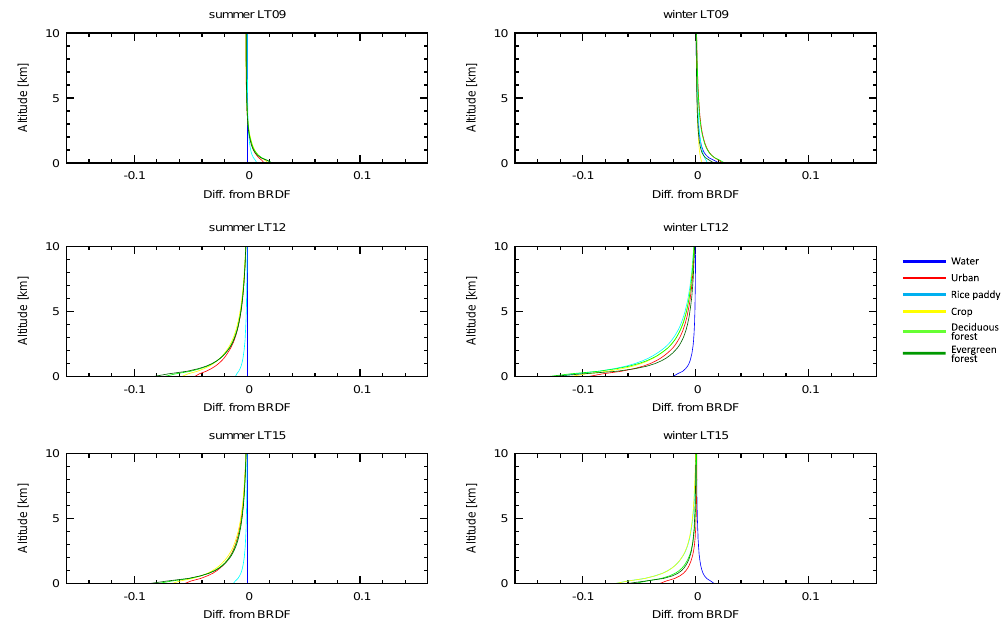
Figure 10. Relative difference of tropospheric NO 2 BAMF for various land cover types from the tropospheric NO 2 BAMF obtained using full BRDF treatment compared to results implementing the values of BSA surface as LER in the RTM. Panels at 09:00, 12:00, and 15:00LT for summer (left) and winter (right) are shown. The colors indicate land cover types: water (blue), urban (red), rice paddy (light blue), crop (yellow), deciduous forest (light green), and evergreen forest (green). An aerosol optical depth (AOD) of 0.2 is assumed.